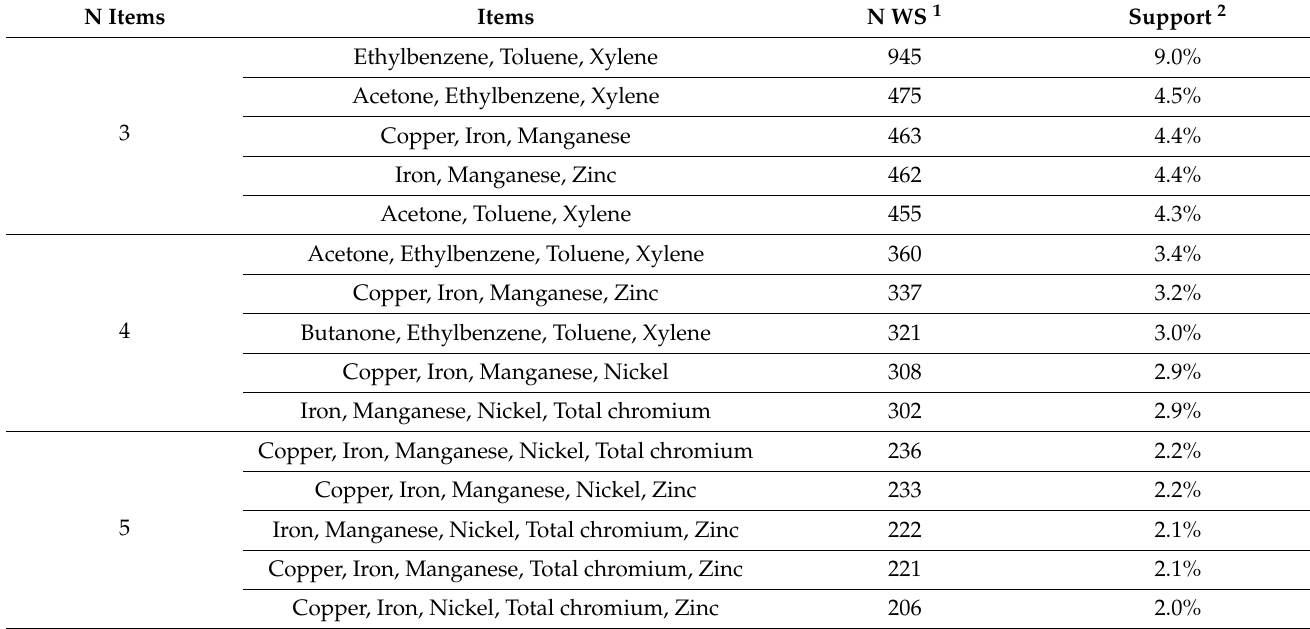
Table 3. Five most frequent itemsets containing 3, 4, or 5 items among WS exposed to at least 2 different